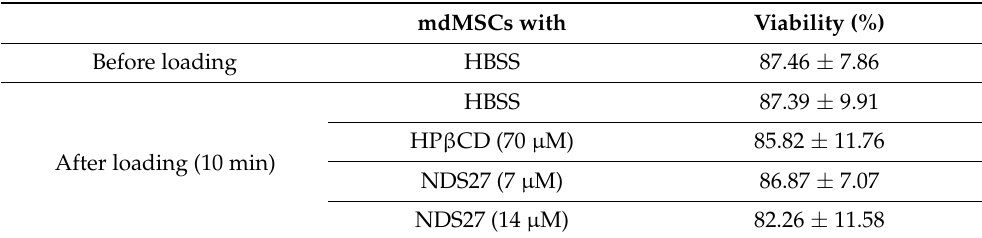
Table 3. Viability of mdMSCs after their loading with 70 µ M HP β CD, or with NDS27 at 7 µ M or 14 µ M. Non-loaded cells were in the presence of HBSS. Mean ± SD, n = 5